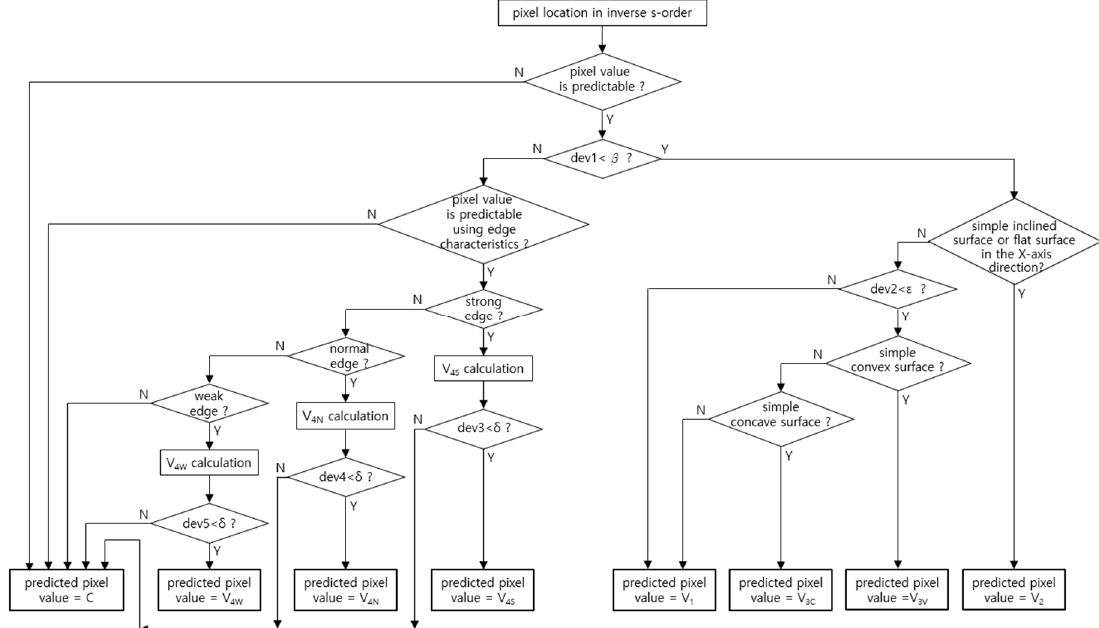
Figure 6. Flowchart of pixel value prediction to generate the prediction image.